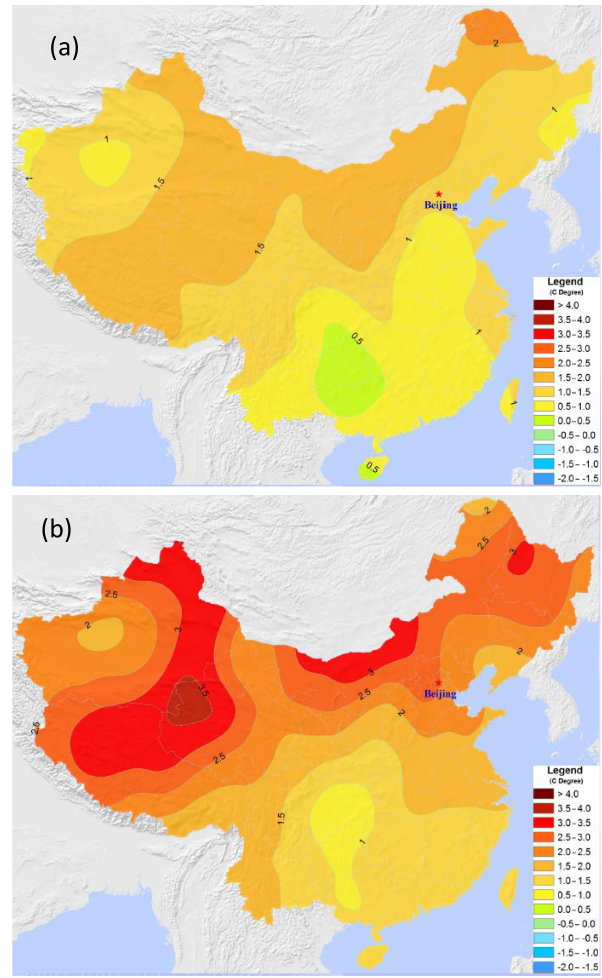
Figure 2. Trends in spatially interpolated (a) mean daily maxi- mum and (b) minimum temperatures ( ◦ C/100 years) in China be- tween 1956 and